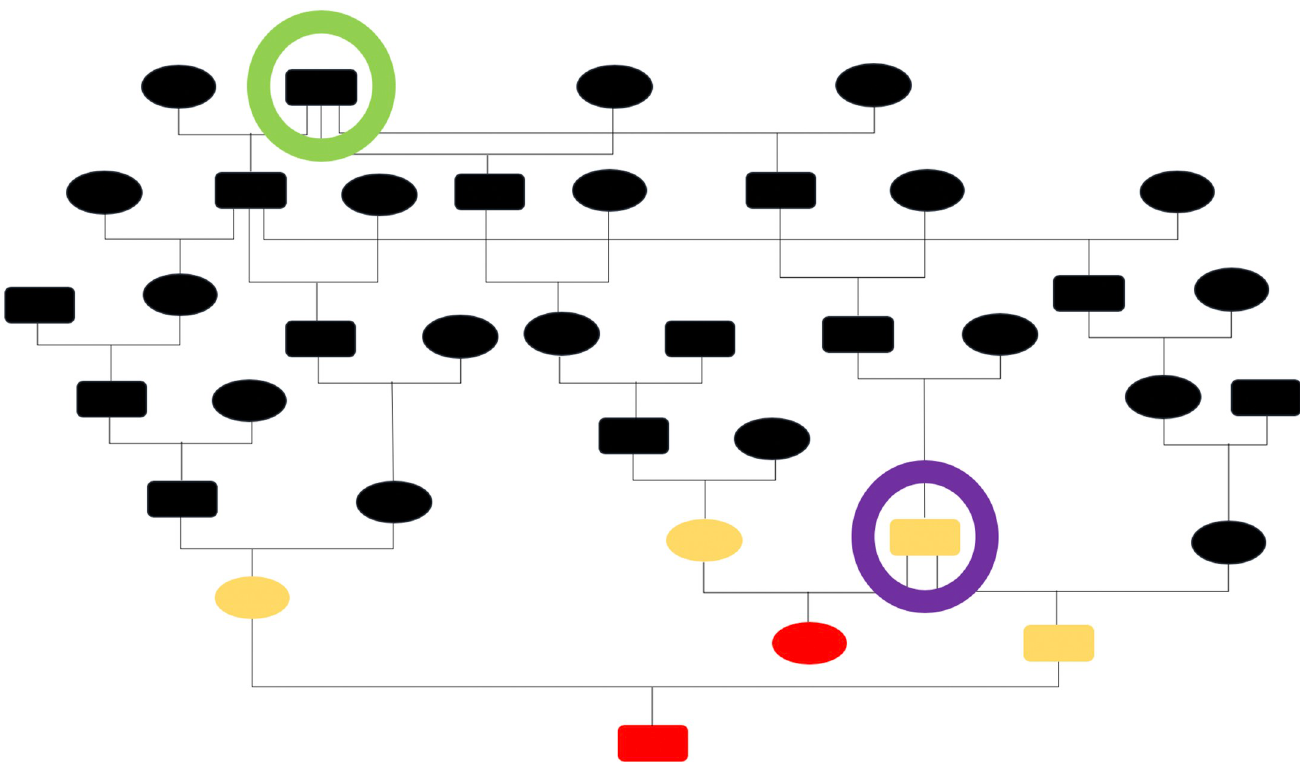
Fig 1. Pedigree of proband Thoroughbred foals affected with idiopathic hypocalcemia. A pedigree analysis was performed on the two proband affected foals ( Cases #1 and 2 ) using Pedigraph (8). The sire of one affected foal was found to be the other affected foal’s grandsire (purple circle). Additionally, foals were related on the dam lines within six generations (green circle). Circles = females, squares = males, red = affected foals, yellow = unaffected horses, black = horses unavailable for evaluation.